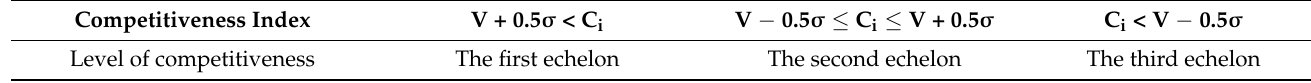
Table 2. Standard of talent competitiveness level in intelligent